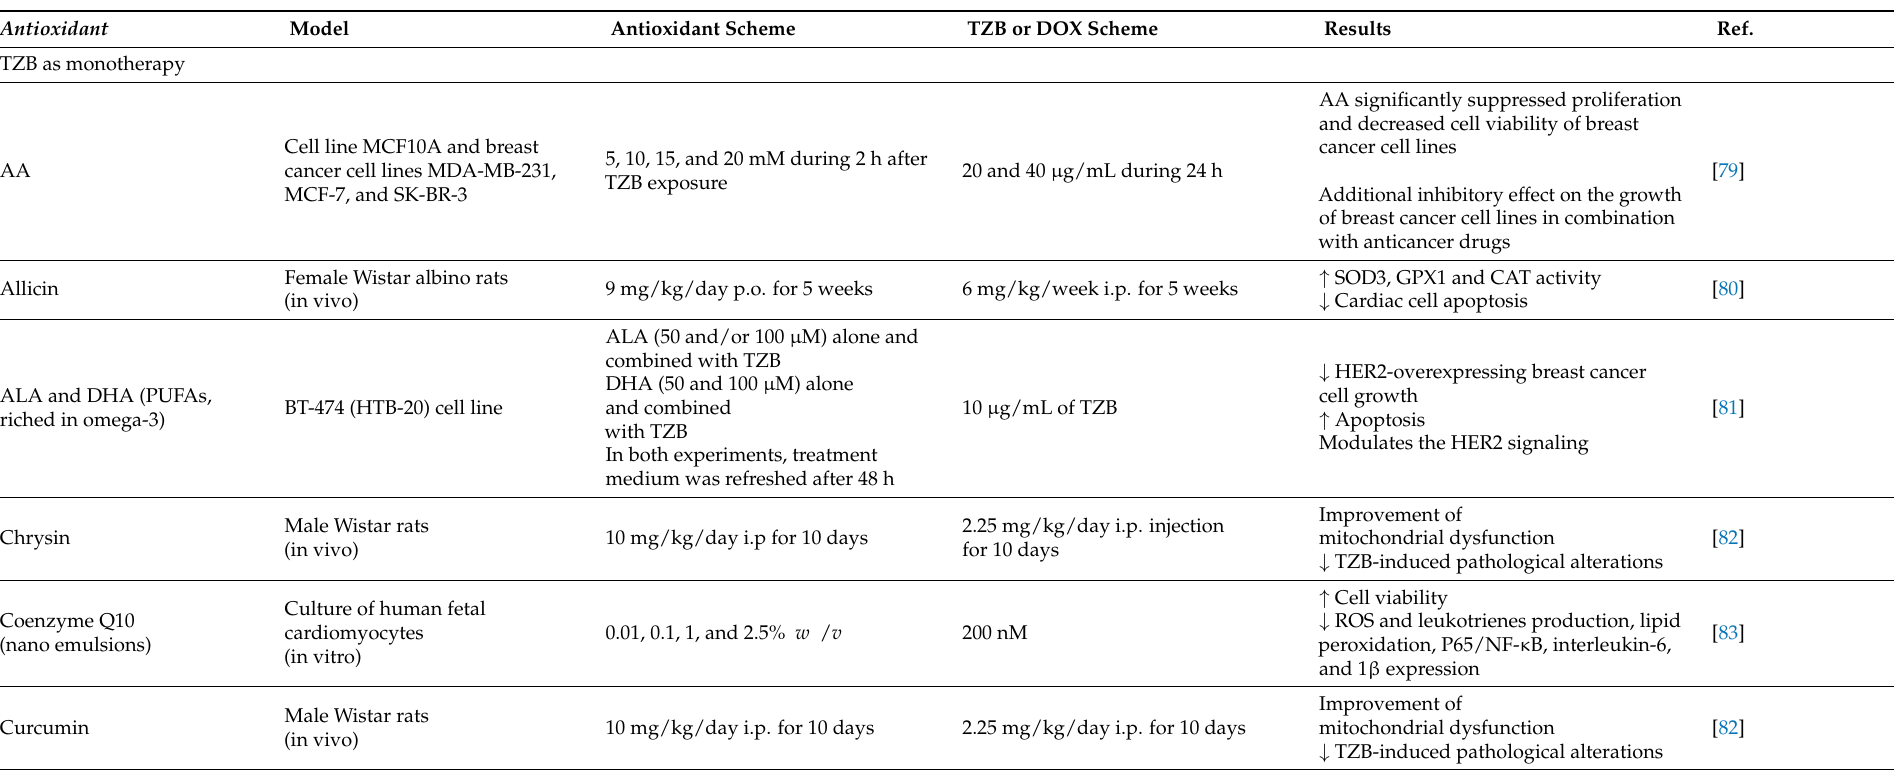
Table 1. Results of studies on the cardioprotective effects of antioxidants or drugs with antioxidant effects against trastuzumab toxicity. 1400 W, N-(3-(aminomethyl) benzyl) acetamidine; AA, ascorbic acid; Ab, antibody; ALA, α -linolenic acid; BAX, BCL2-associated X protein; Bcl-XL; B-cell lymphoma-extra-large; CAT, catalase; CK-MB, creatine kinase MB; CoQ10; Coenzyme Q10; COX, cyclooxygenase; cTn-I, cardiac troponin I; DHA, docosahexaenoic acid; DOX, doxorubicin; EF, ejection fraction; FS, fractional shortening; GPX, glutathione peroxidase; GST, glutathione S-reductase; HER2, human epidermal growth factor receptor 2; IL-6,